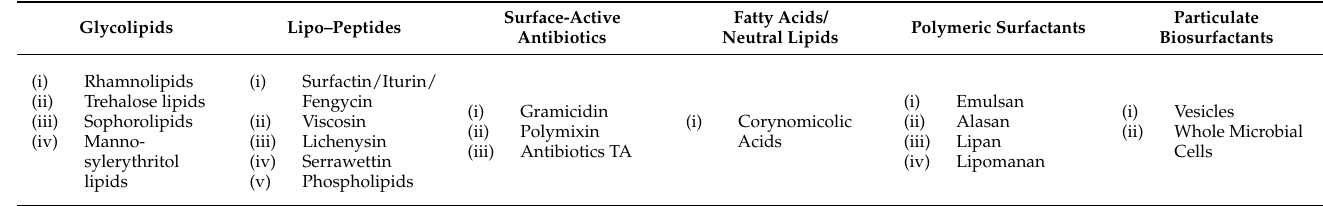
Table 1. Types of biosurfactants—according to the